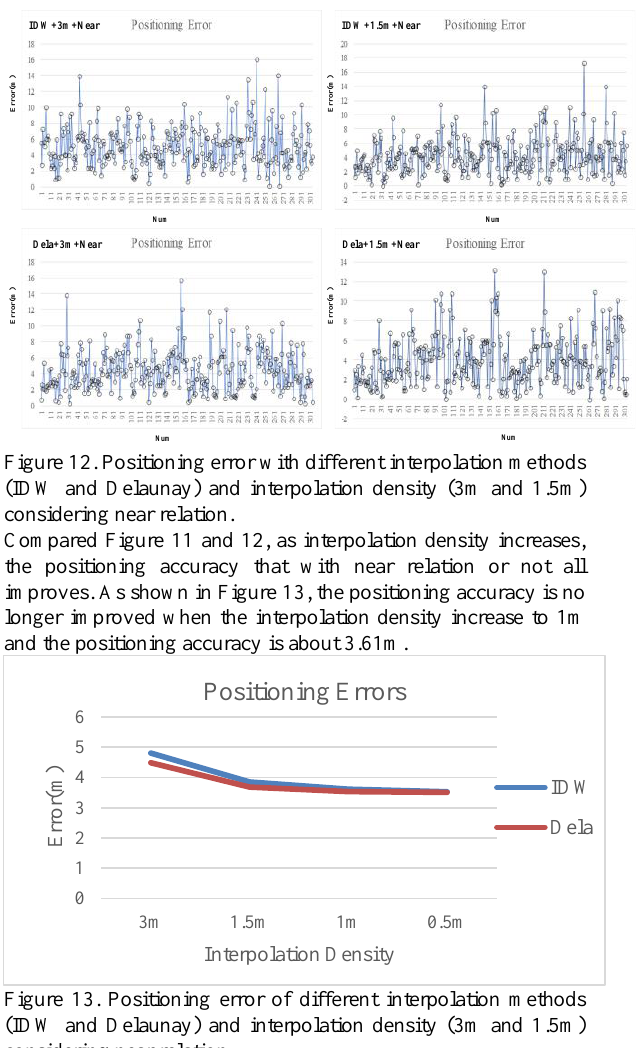
Figure 9. Positioning error with non-interpolation and Delaunay-based interpolation density of 3m.